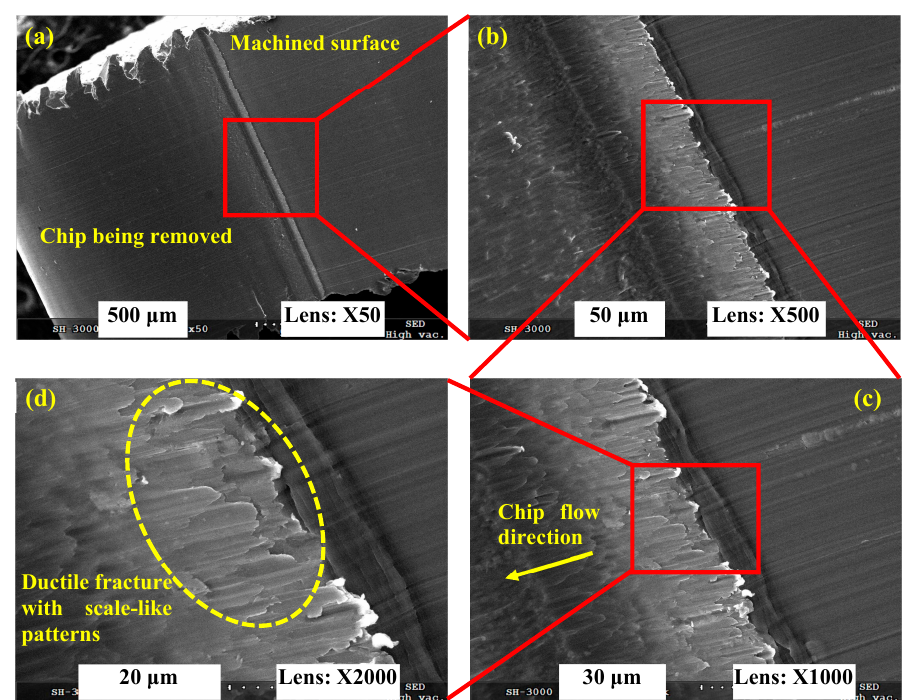
Figure 7. SEM micrographs of chip root for Inconel 718 produced under V = 1000 m/min. ( a ) macroscopic morphology of chip root; ( b – d ) indicate microscopic morphologies of magnified areas shown in ( a – c ). Materials 2018 , 11 , x FOR PEER REVIEW